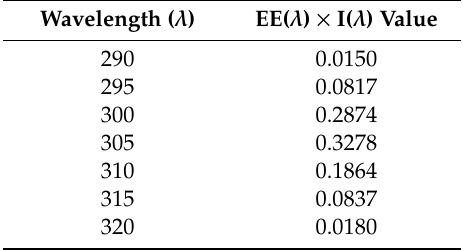
Table 1. EE( λ ) × I( λ ) value of each of the wavelengths used to determine the sun protection factor